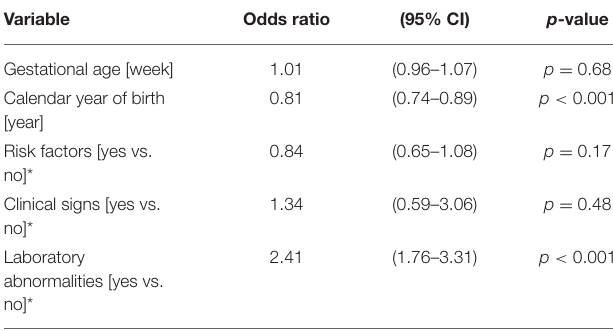
TABLE 4A | Ordered logistic regression: duration of antibiotic therapy by gestational age, calendar year of birth, risk factors, clinical signs, and laboratory abnormalities.